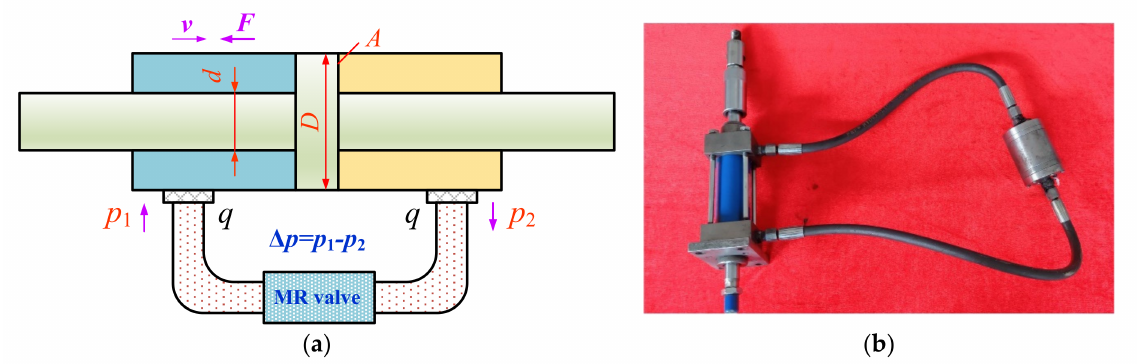
Figure 15. Working principle diagram and prototype of the MR valve controlled cylinder system: ( a ) working principle diagram, ( b )